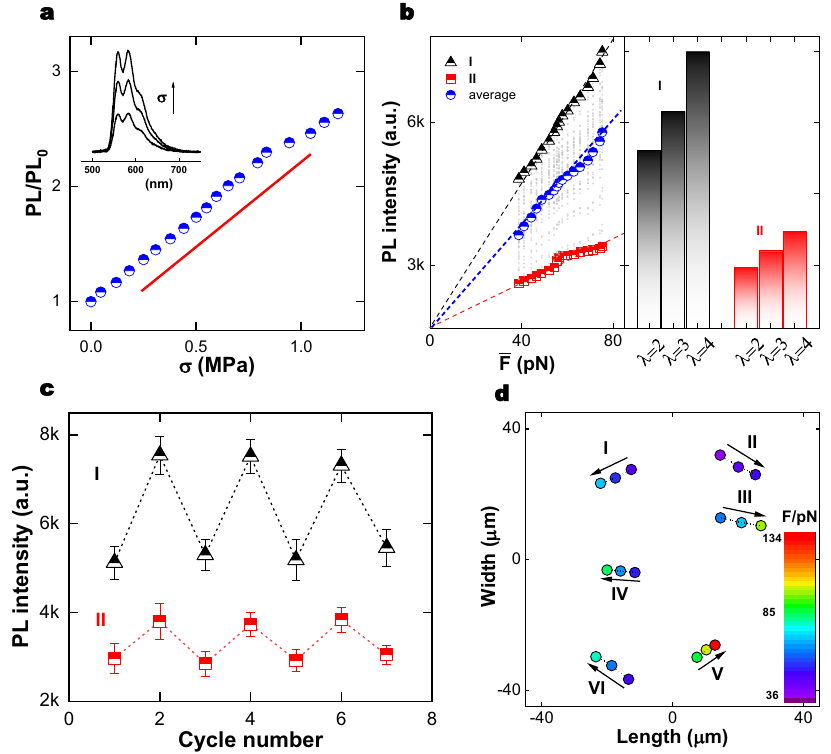
Fig. 3 | Force within individual crosslinks. a Photoluminescence (PL) of the macroscopicsampleisproportionaltostressonthesample.Inset:thePLspectrum shows increased intensity but the same peak shape with increasing stress. b PL intensity plotted against average estimated force on each crosslink, for two indi- vidualcrosslinks(IandII)andfortheaverageof50crosslinks.Thisisaccompanied byPLhistograms(IandII)atthreeindicatedelongationratios. c PLintensityplotted